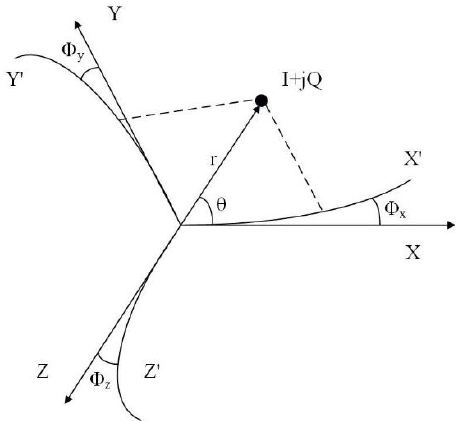
Figure 4. Signal decomposition based on the phase response of the VGA.